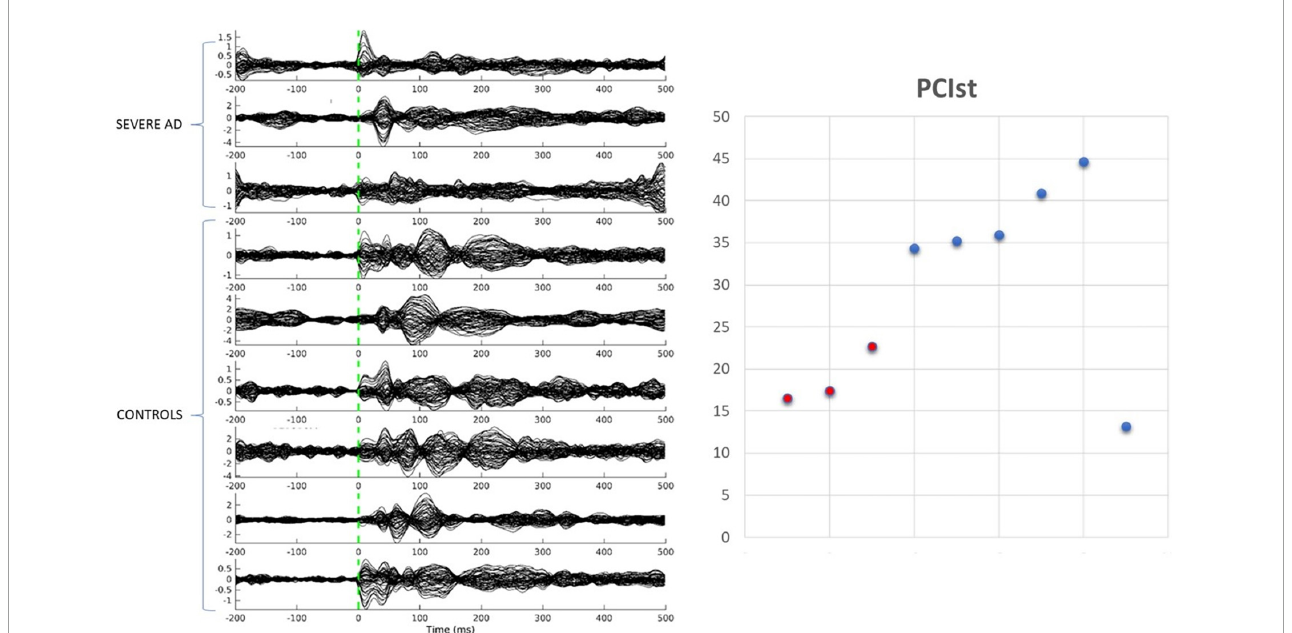
FIGURE2 Transcranial magnetic stimulation evoked potentials and PCIst values for control participants and patients with severe AD.